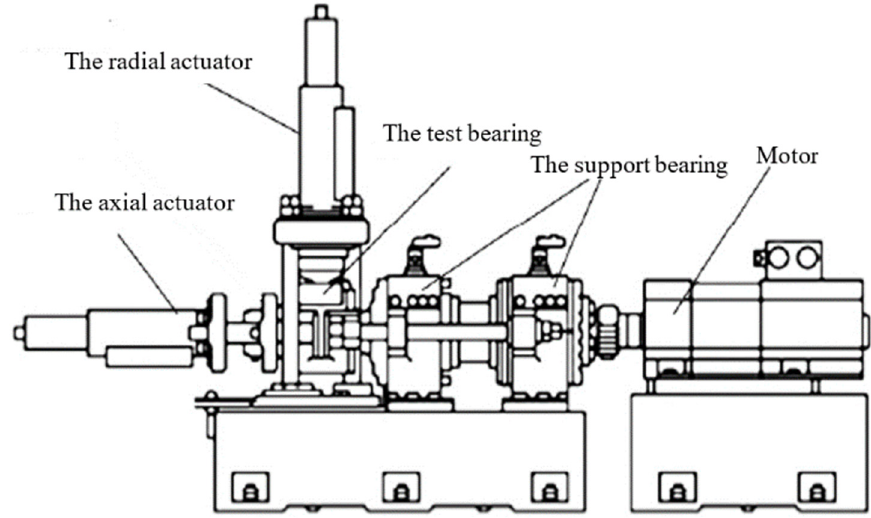
Figure 7. The test bench’s architecture for the high-speed train wheelset bearing.